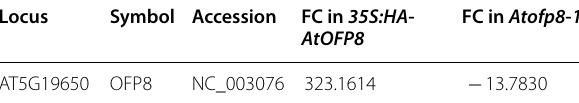
Table 2 The transcription level of AtOFP8 in 35S:HA - AtOFP8 overexpression plants and Atofp8 - 1 mutant Locus Symbol Accession FC in 35S:HA ‑ FC in Atofp8 ‑ AtOFP8